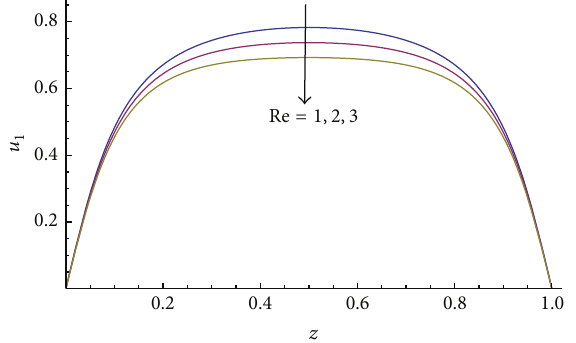
Figure 5: The influence of the Reynolds number Re on the velocity profile 𝑢 1 (𝑦,𝑧,𝑡) with 𝑦 = 0.1 , 𝑡 = 0.3 , 𝛼 = 2 , 𝛽 = 0.8 , 𝜆 1 = 5 , = 2 , and 𝜆 = 1 . 𝜆 2 3